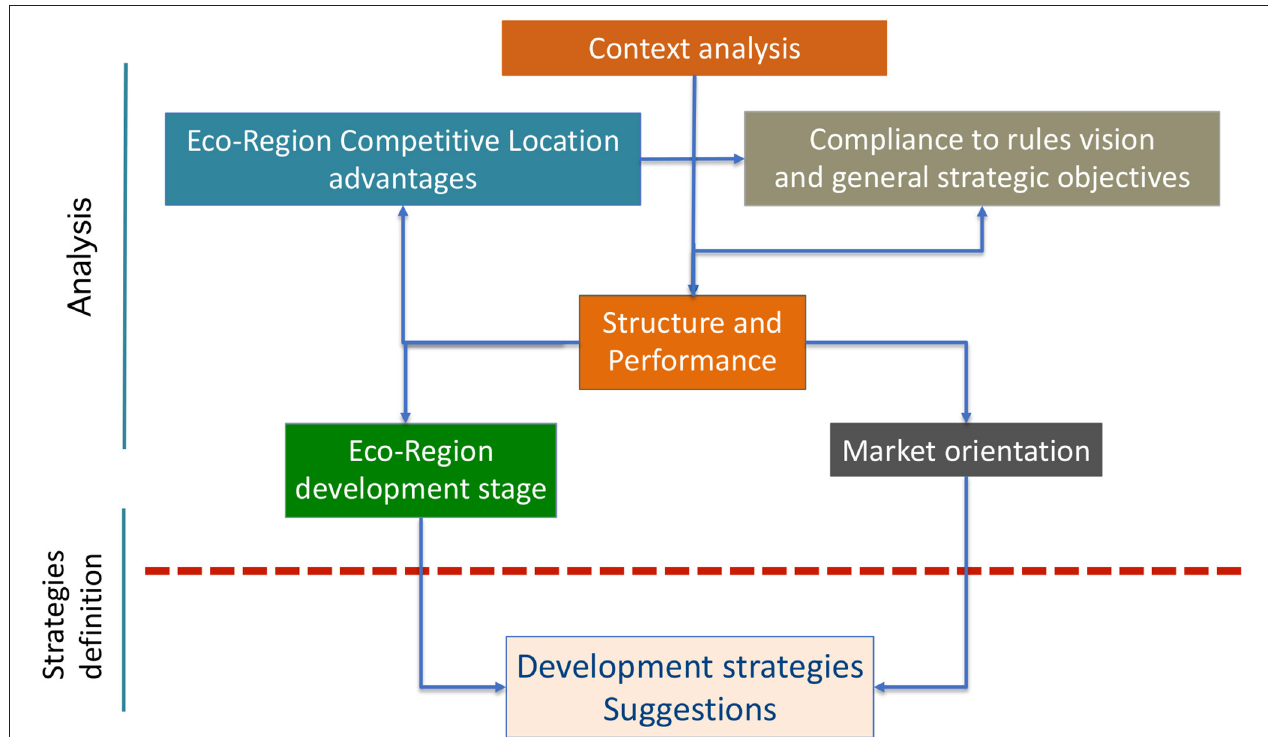
FIGURE 2 | Eco-Regions’ Monitoring tool modules. Adapted from Pugliese et al. (2013) with permission from CIHEAM Bari.